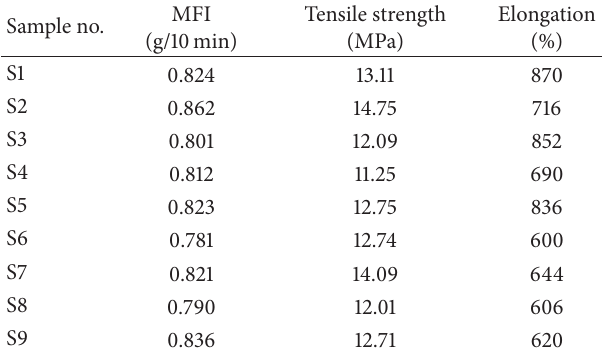
Table 6: MFI and tensile data for control and various blend samples. Sample